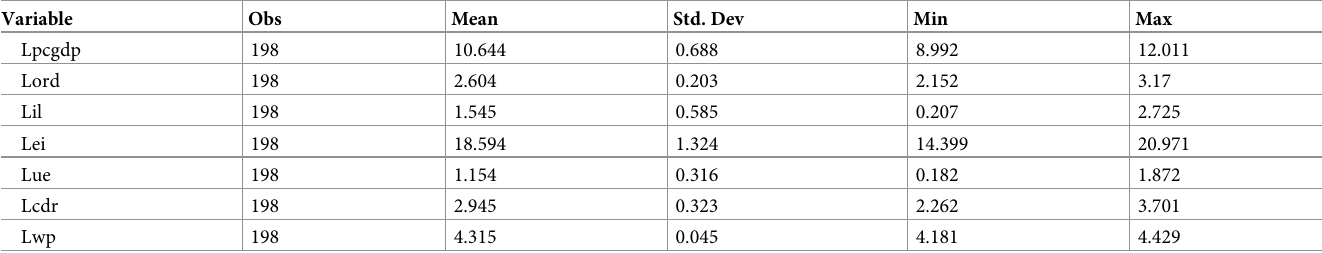
Table 3. Descriptive statistics of eastern region of